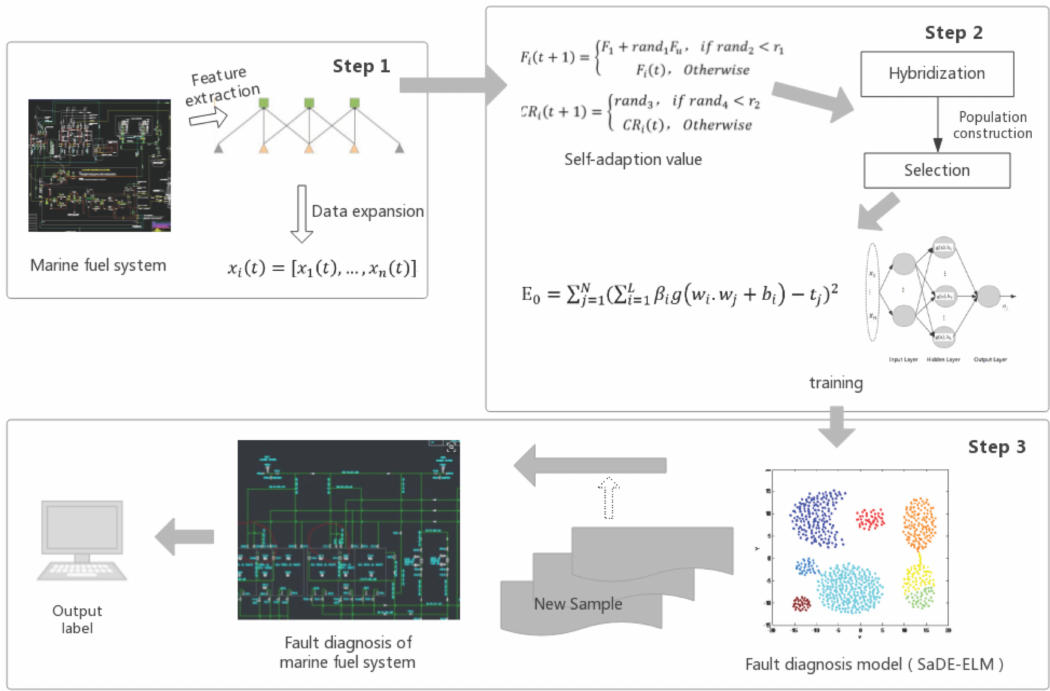
Figure 1. Research